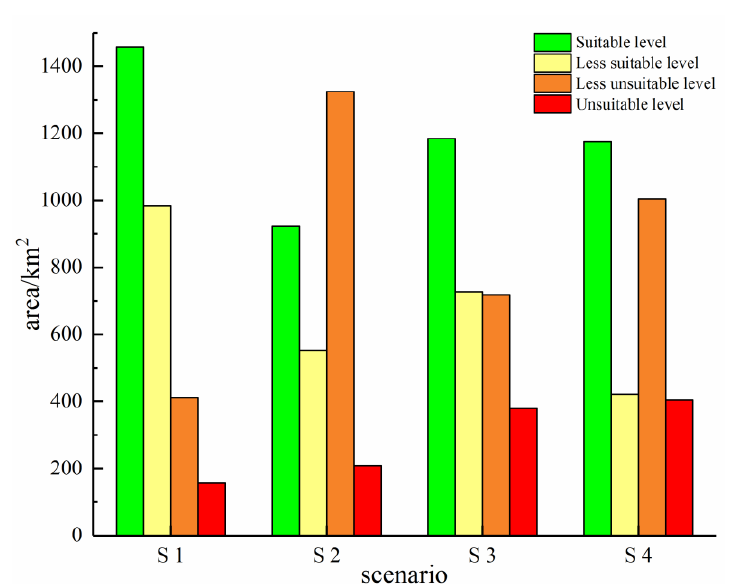
Figure 9. Area distribution of habitat suitability level. (S1): Wet year, no hydraulic project; (S2): Dry year, no hydraulic project; (S3): Wet year, hydraulic project present / operating; (S4): Dry year, hydraulic project present / operating.